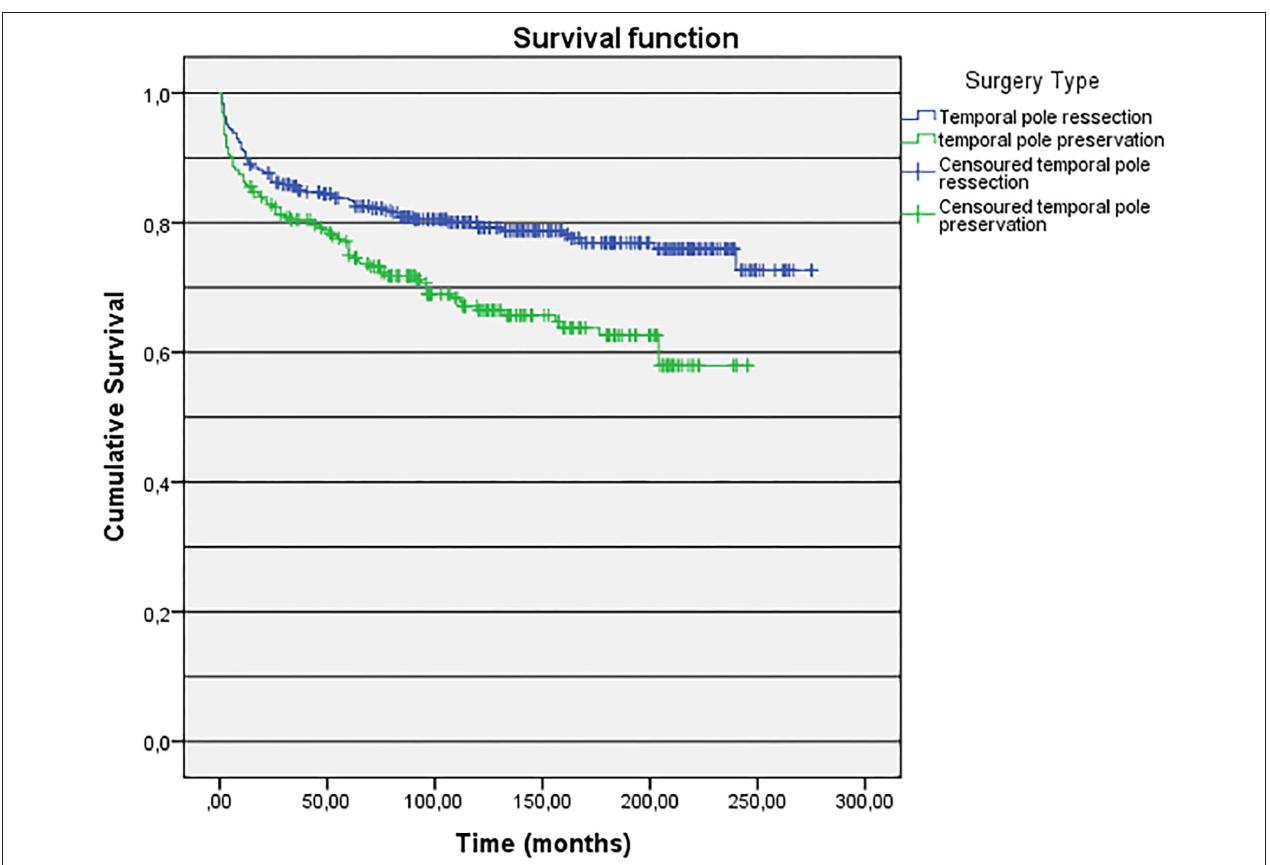
FIGURE 4 | Kaplan-Meier curve of long-term seizure outcomes according to type of